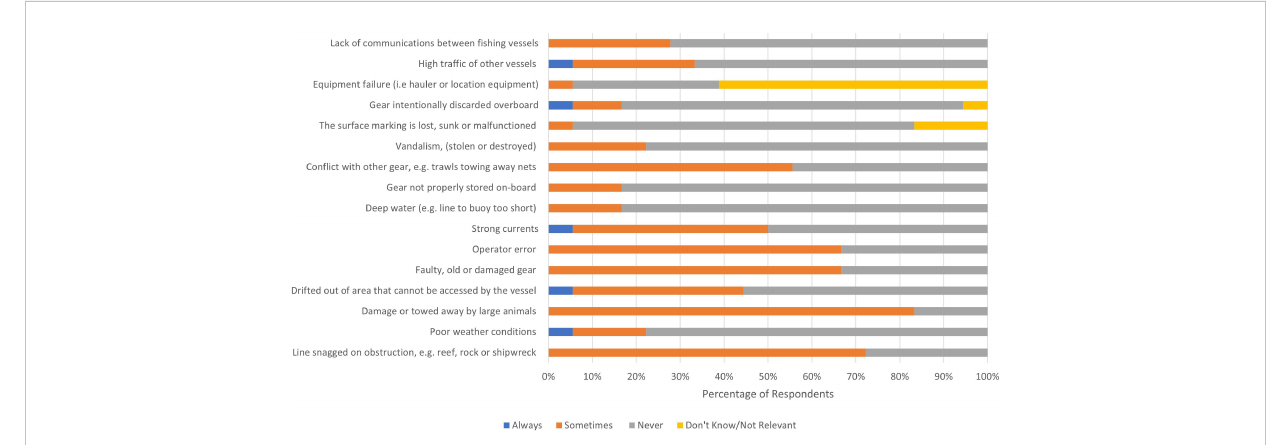
FIGURE 4 Summary of interview results from Dominica to the question: “ When a vessel loses hooks or lines, what are the main causes of the gear loss and corresponding frequency of occurrence? ” (n = 18).